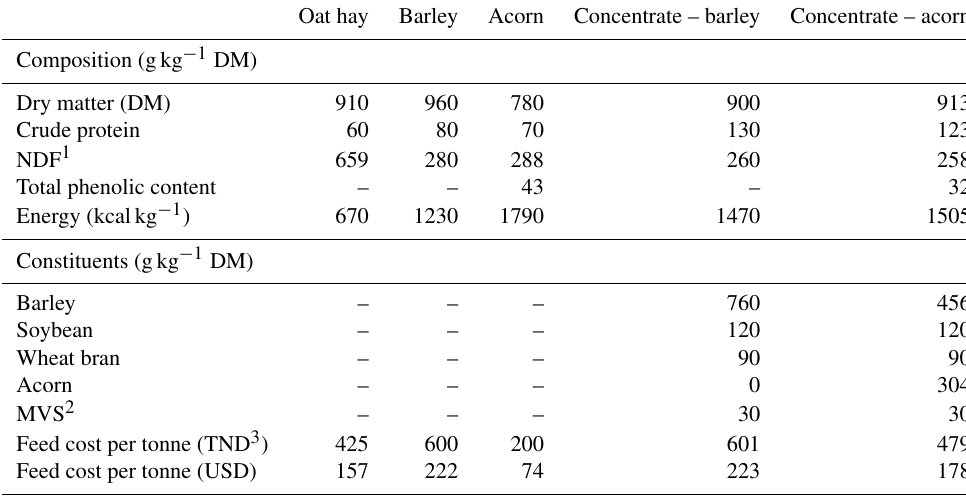
Table 1. Chemical composition (gkg − 1 dry matter, DM) and costs of experimental foods. Oat hay